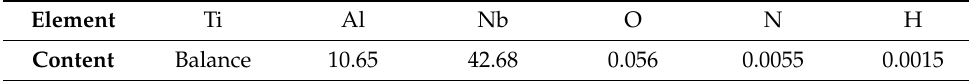
Table 1. Chemical compositions of Ti 2 AlNb-based alloys (wt.%).